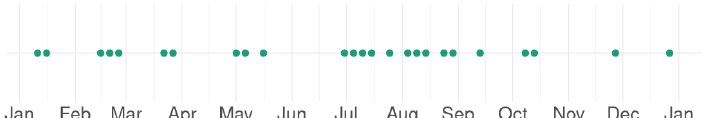
Figure 5. Overview of the acquisition dates of Sentinel-2 (S2) images over Haute-Garonne . S2 acquisitions are sparsely distributed due to the ubiquitous